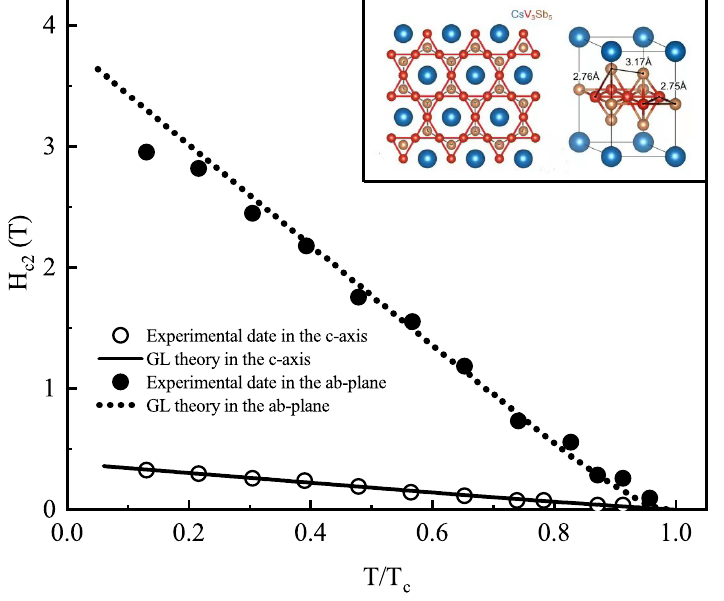
(cid:107) c (cid:107) ab (solid line) and H (dotted line) as function of temperature. The c 2 c 2